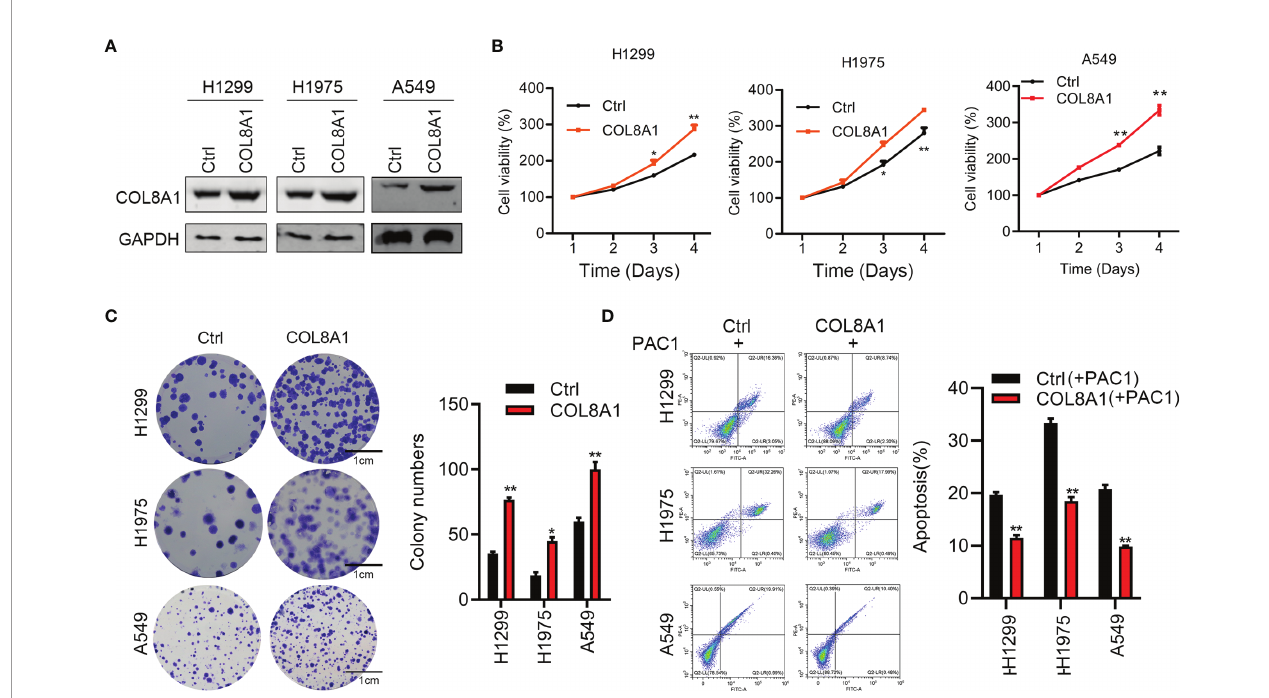
FIGURE 3 | Overexpression of COL8A1 contributes to cell proliferation, invasion and cell cycle of NSCLC cells. (A) The ef fi cacy of COL8A1 overexpression was examined by Western blot. (B) Effects of COL8A1 overexpression on cell proliferation were examined by cell viability assay in A549, H1299 and H1975 cell lines. (C) Effects of COL8A1 overexpression on colony formation in A549, H1299 and H1975 cell lines. (D) Flow cytometry was performed to examine cell apoptosis of COL8A1-overexpressing NSCLC cells. *p<0.05.